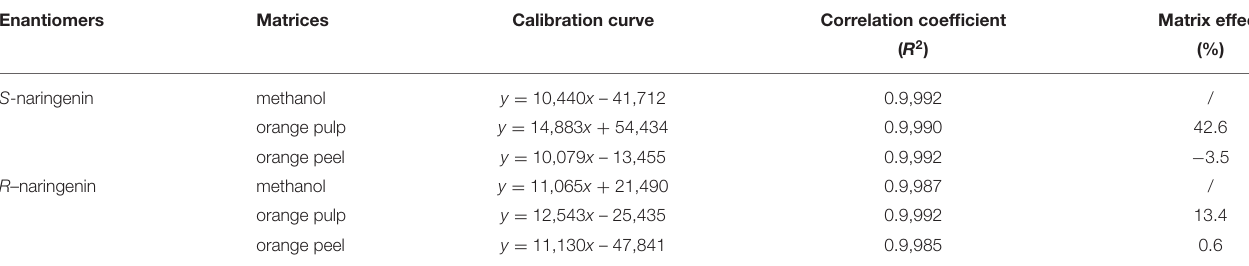
TABLE 1 | Comparison of solvent and matrix standard curves and matrix effects of naringenin enantiomers. Enantiomers